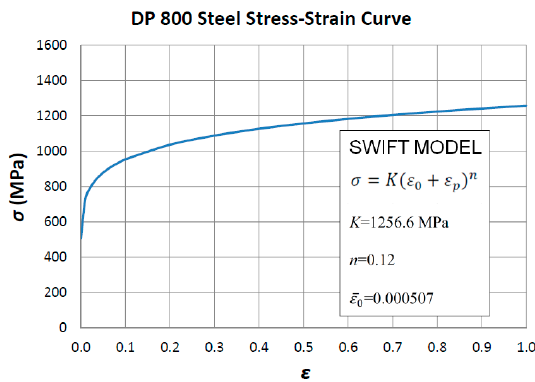
Figure 2. Flow curve of dual-phase steel DP800.